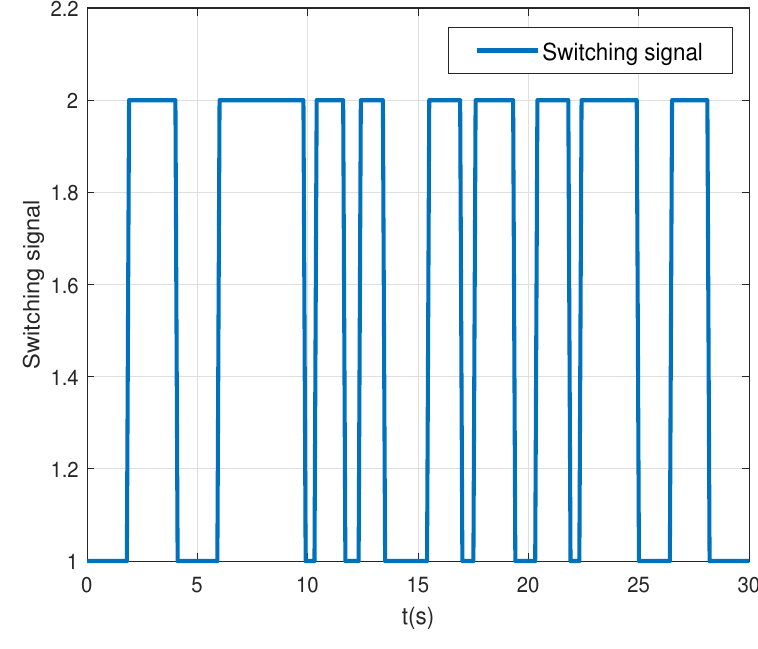
Figure 1. Switching signal.